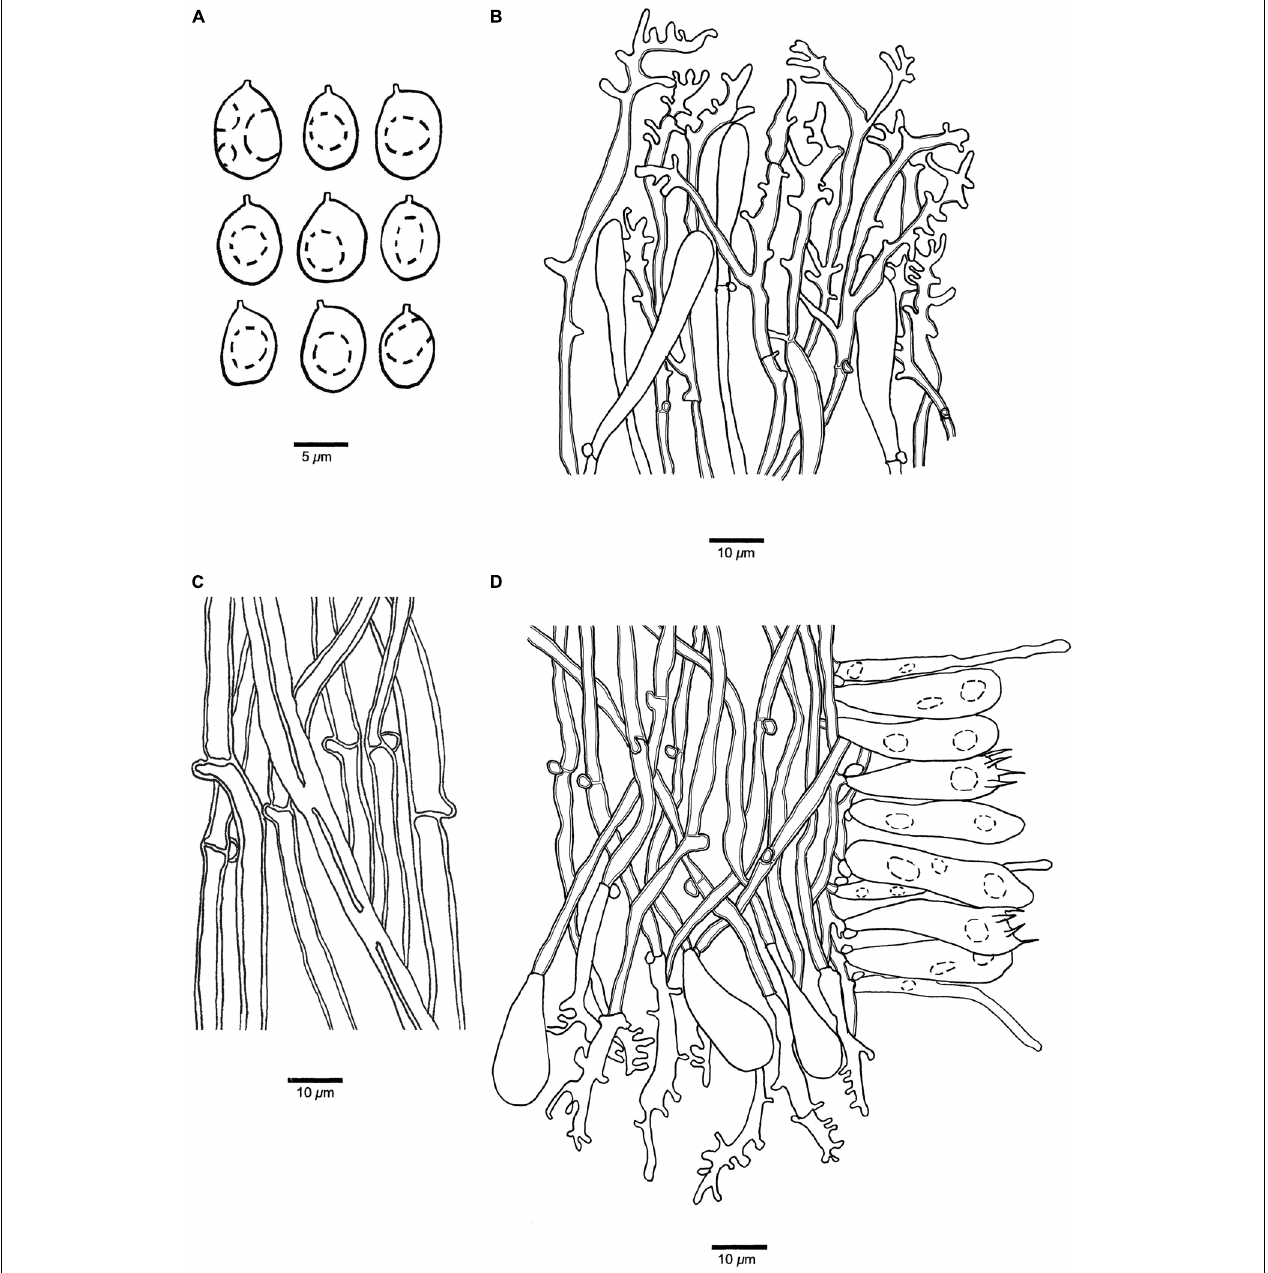
FIGURE 7 | Microscopic structures of Panellus longistipitatus (holotype). (A) Basidiospores. (B) Dichophysial hyphae and pileocystidia from pileipellis. (C) Hyphae from stipe. (D) A section of tube trama, including pleurocystidia, cheilocystidia, basidia, and basidioles. The dotted circles represent some guttules in basidiospores, basidia or